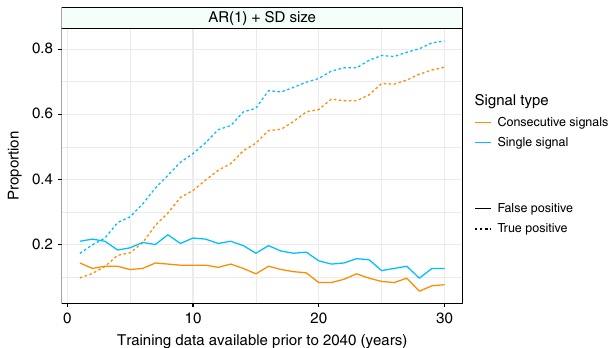
Fig. 6 The effects of the amount of training data available on the proportion of false positive and true positive warning signals prior to the recovery of cod stocks for AR(1) + SD size. As the amount of training data available increased so too did the predictive accuracy of the method, with a high proportion of true positive (dashed lines) and low proportion of false positive (sold lines) signals when 30 years of training data are available. The consecutive signal approach (orange lines) provided consistently more cautious predictions (lower proportion of false positive and true positive signals than the single signal approach, blue lines) The 2 σ threshold proposed for determining the presence of warning signals 14 performed well in comparison to other threshold values, typically producing low FP ratios and high TP ratios when either a single signal, or consecutive signal approach was taken (Fig. 7). Of the 15 metrics tested AR(1) + SD size produced the best TP to FP ratio across the thresholds tested (Fig. 7).